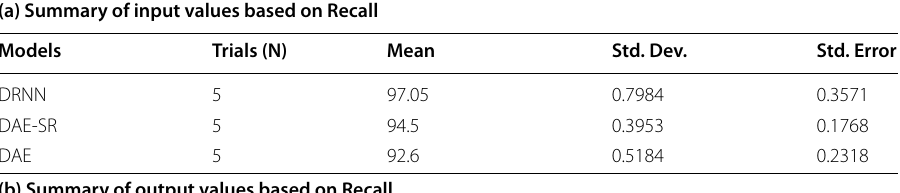
(b) Summary of output values based on Recall Source Among groups Within